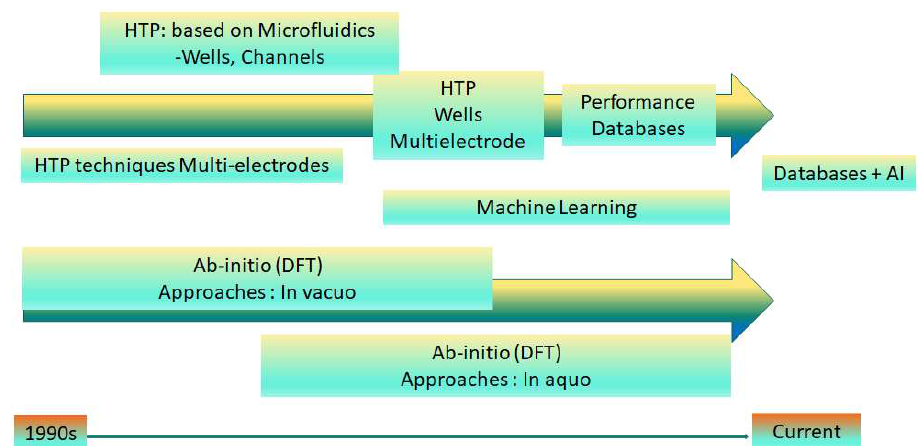
Figure 1. Timelines of progress in a range of approaches to the discovery of new inhibitors, includ- ing high-throughput (HTP) techniques; machine learning (ML) and artificial intelligence (AI); and ab initio approaches, such as density functional theory (DFT).